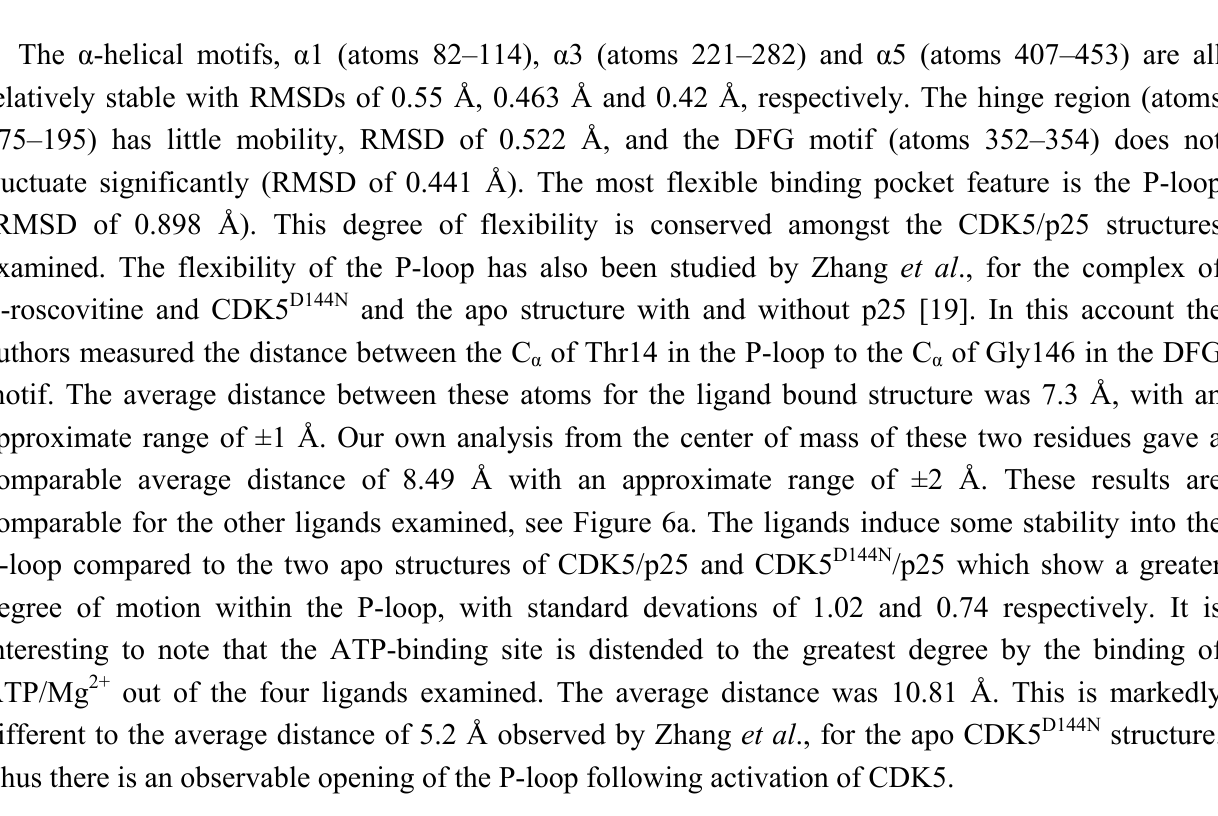
Figure 6. Probability distributions for the distances: ( a ) between the center of mass of Thr14 and Gly146 in CDK5 structures; and ( b ) between the center of mass of Ala28 and Gly162 in ERK2, Ser42 and Gly178 of GSK3 β and between the center of mass of Thr14 and Gly146 in